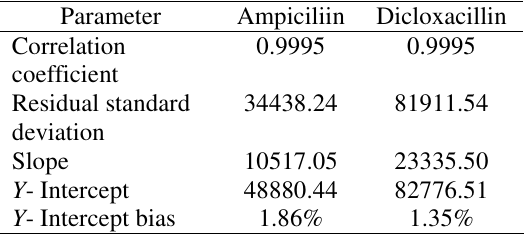
Table 5. Evaluation of chromatographic parameter for ampicillin and dicloxacillin capsules dosage form.